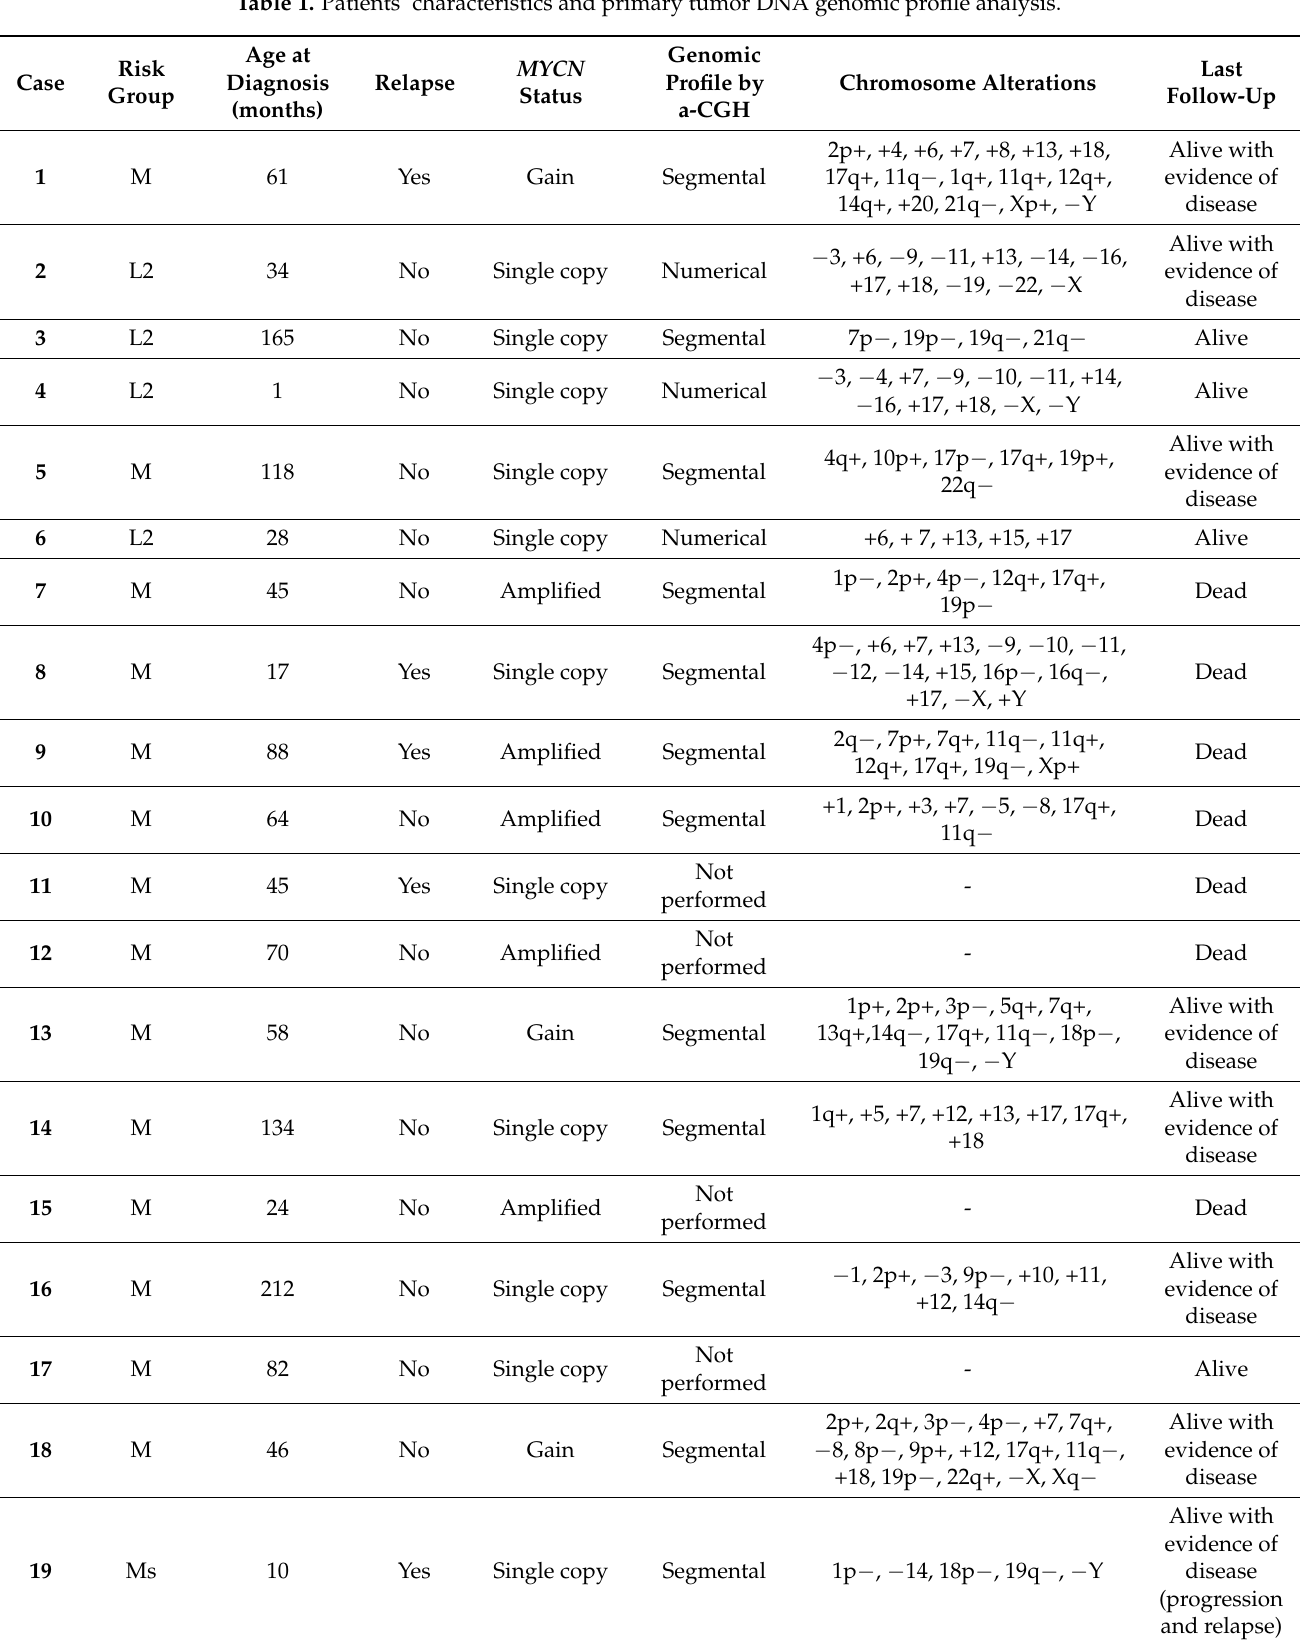
Table 1. Patients’ characteristics and primary tumor DNA genomic profile